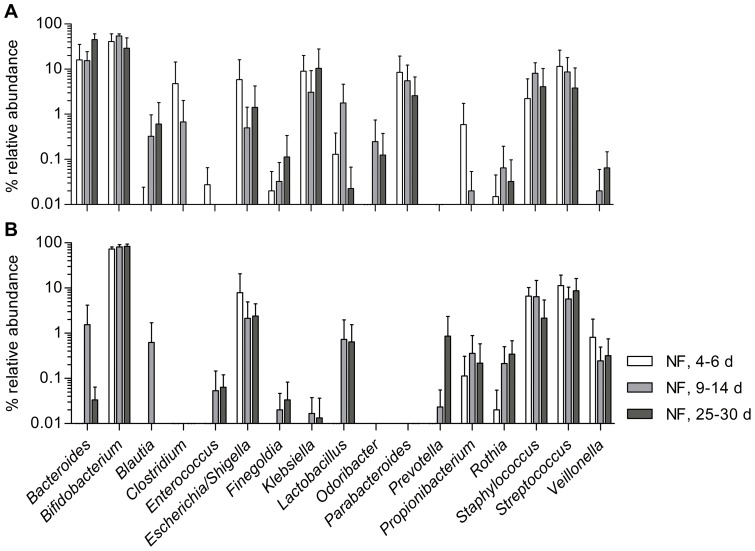
Relative 16S rRNA gene abundances of the 17 most abundant genera detected in neonatal feces (NF) using pyrosequencing.Values are expressed as means ± SD at each of the three sampling points, i.e. days 4–6, 9–14 and 25–30 postnatal in neonates harboring high (A, n = 4) and low (B, n = 3) Bacteroides population levels, respectively.